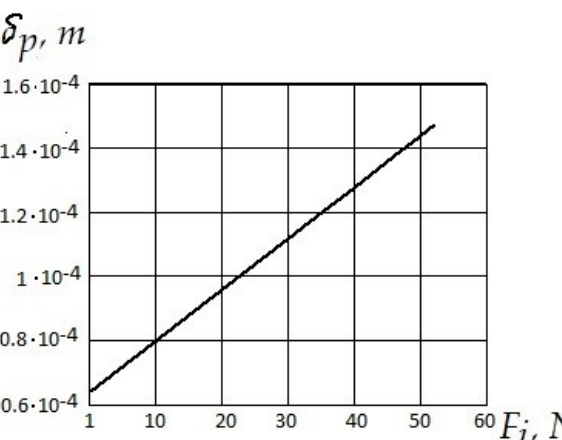
Figure 9. The dependence of the allowable deformation of the polymer layer on the shear force.